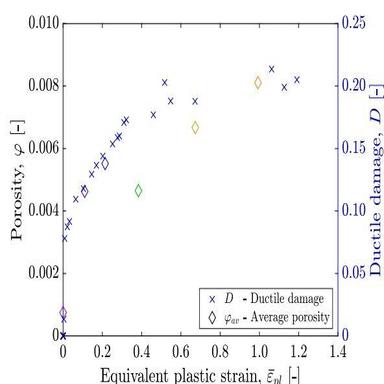
Analysis of the porosity and ductile damage evolution with equivalent plastic strain.